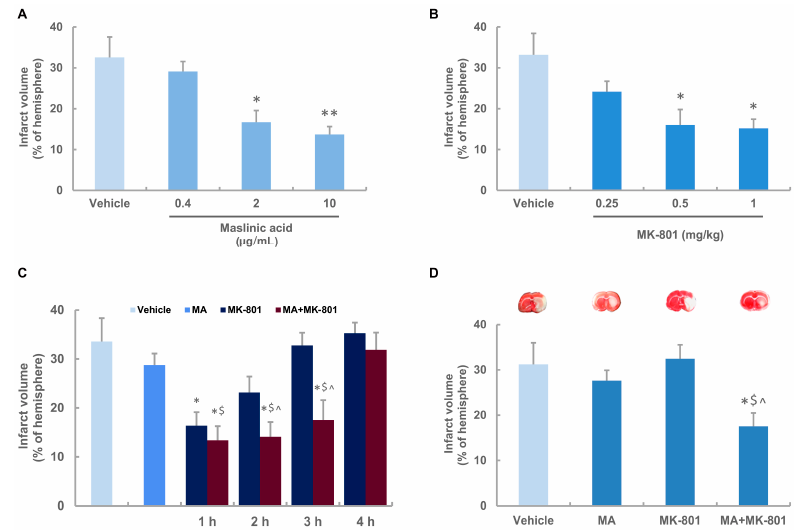
Figure 2. Neuroprotective effects of maslinic acid and MK-801 on focal cerebral ischemia in